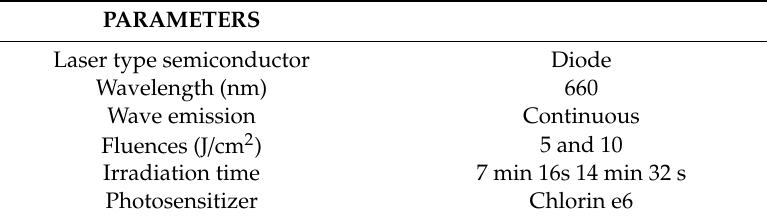
Table 1. Laser parameters for photodynamic